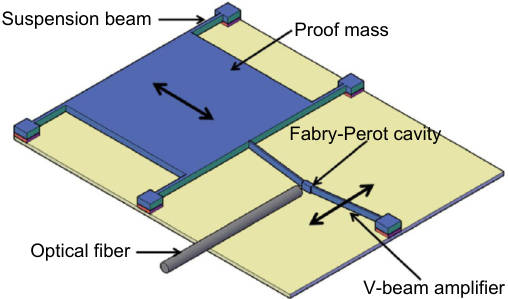
Fig. 20 | Schematic of a V-beam amplified Fabry-Perot cavity based accelerometer. Figure reproduced with permission from ref. 96 ,